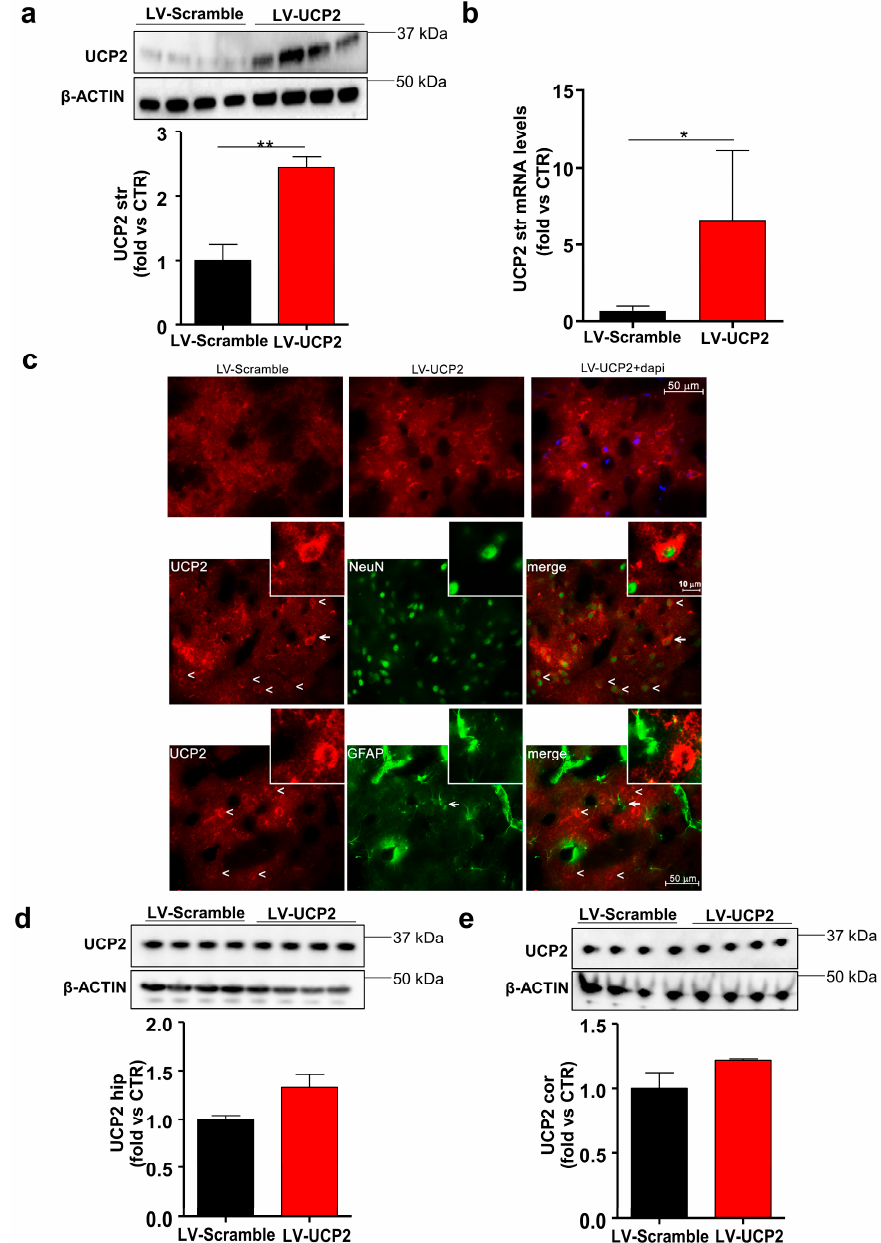
Figure 3. Overexpression of UCP2 in the striatum of JD-fed SHRSP rats, receiving a single i.c.v. injection of LV-UCP2. UCP2 protein and mRNA levels in the striatum of JD-fed SHRSP rats receiving a single i.c.v. injection of LV-UCP2 or the empty vector (LV-Scramble) are shown in ( a , b ), respectively. Values are means ± S.E.M. of 6 animals per group. * p < 0.05; ** p < 0.001 (Student’s t test). Animals were killed at the time of the first stroke episode. Immunohistochemical analysis of UCP2 in one representative animal from the two groups is shown in ( c ). DAPI was used as blue fluorescent nucleic acid stain. Double fluorescent staining of UCP2 (red) and either NeuN (green) or GFAP (green) is shown in the lower panel. Arrowheads indicate UCP2 immunoreactive cells, whereas arrows indicate cells shown in the insert at higher magnification. UCP2 protein levels in the hippocampus and cerebral cortex of the two groups of animals are shown in ( d , e ), respectively. Values are means ± S.E.M. ( n = 6 in both groups).